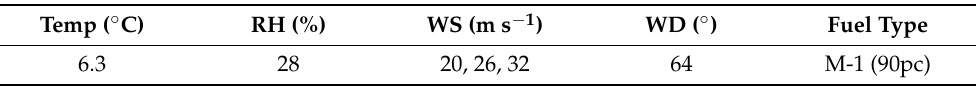
Table 3. Constant upwind weather stream input used for the idealized experiments in Sections 2.5 and